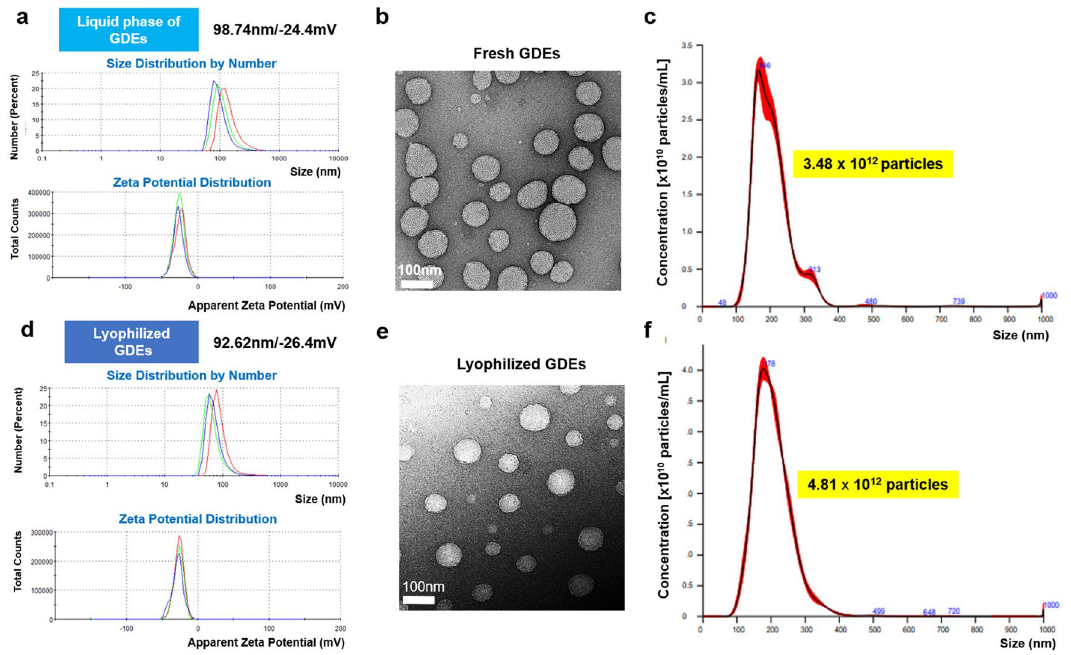
GDEs, respectively. c , f size distribution and particle concentration of GDEs as measured via